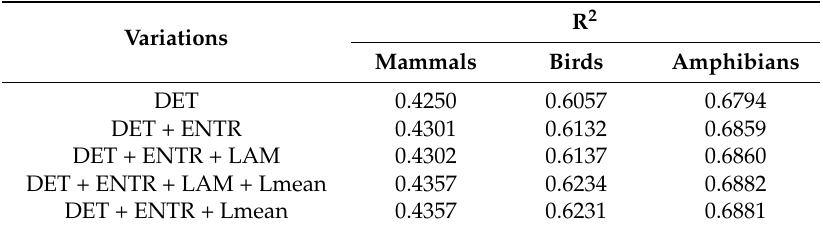
Table 3. Correlation coefficients of species richness, based on field surveys, versus temporal stability incorporated with the long-term mean of ET using the simple linear regression of the raw